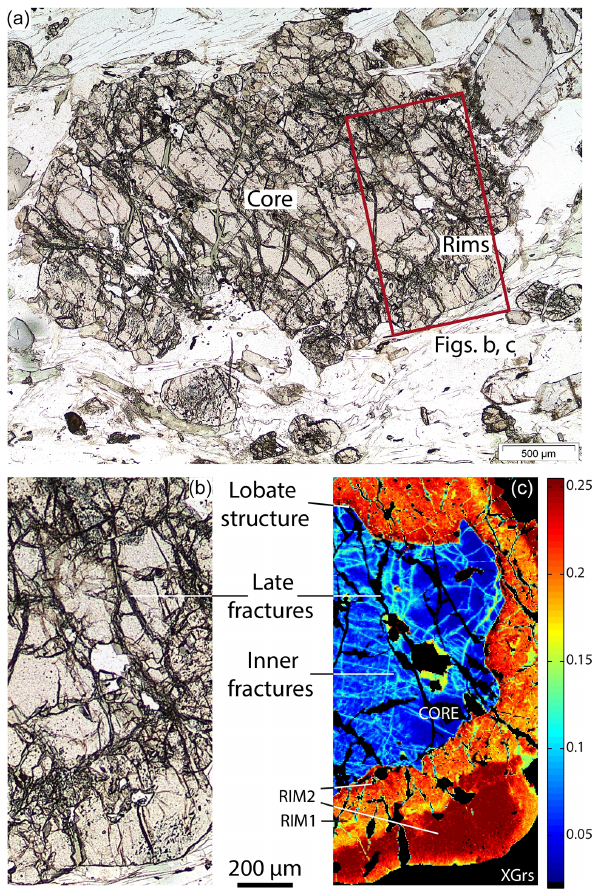
Figure 3. Garnet porphyrocryst in FG12157. (a, b) Optical mi- crophoto and plane polarized light. (a) Clear lobate core, dark in- ner rim, speckled with inclusions (mostly rutile, up to 20µm long), outer rim more clear with only minor inclusions. (b) Enlargement shows later fractures (dark) that dissect the entire garnet and con- tain chlorite. (c) Grossular X-ray map; blue Ca-poor core reveals numerous micrometre-size fractures sealed by more calcic garnet; sparse late fractures (black) in core and rims. Compare to complete maps in Figs. 4b,